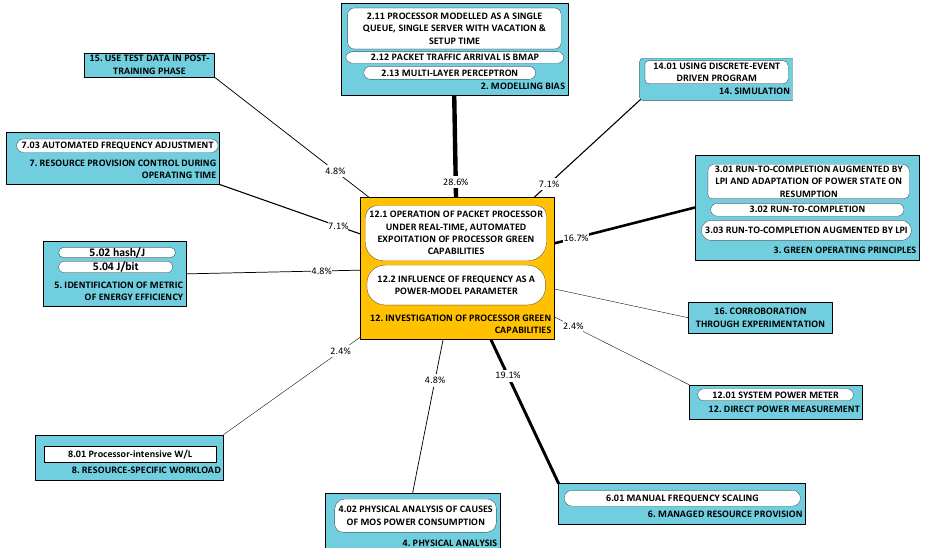
Figure 17. Approaches to solving challenges in category P12; utility metric U (cid:2885) (cid:3169) is shown in line thickness and as a percentage. RUs in the respective categories are the following: P12: [50,60,67,81–